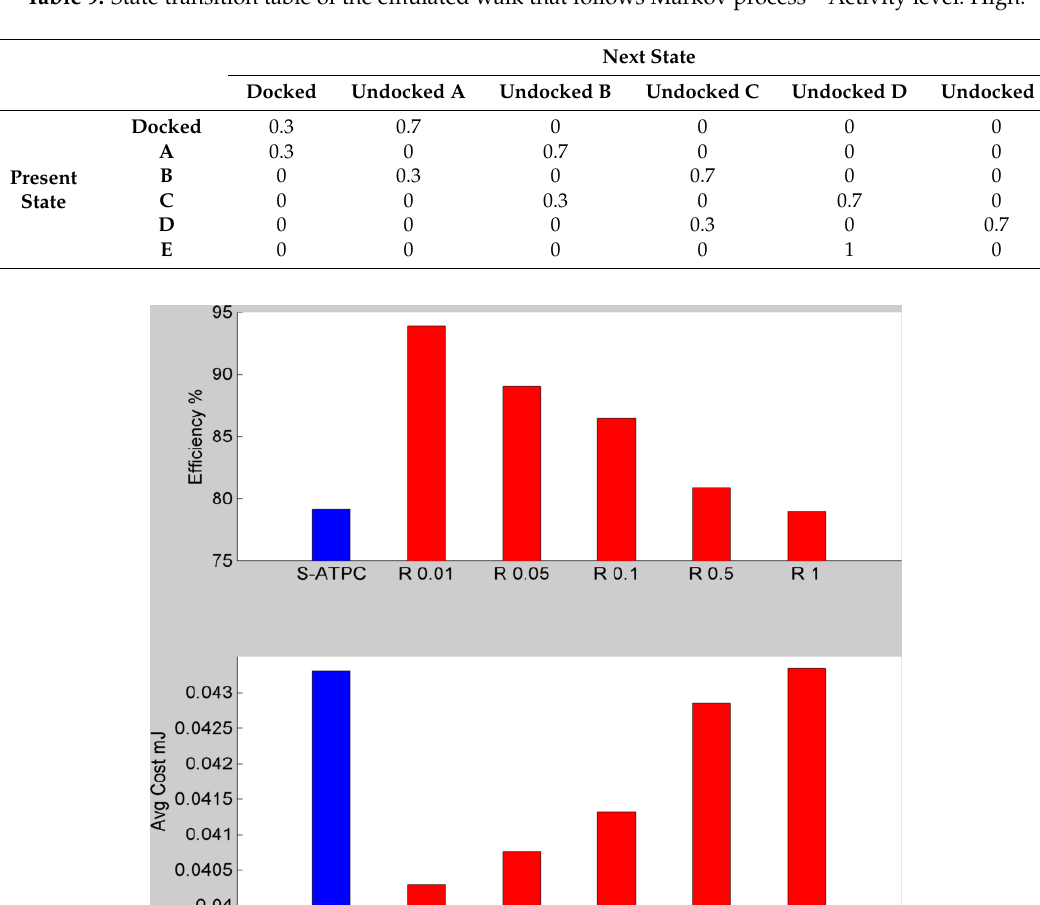
Figure 6. Activity level: High—the protocol efficiencies and the average cost of success transmissions are compared when the PSR for all the cases are equal to 99%.